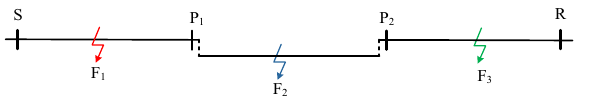
Figure 9. Schematic diagram of type B cable hybrid transmission